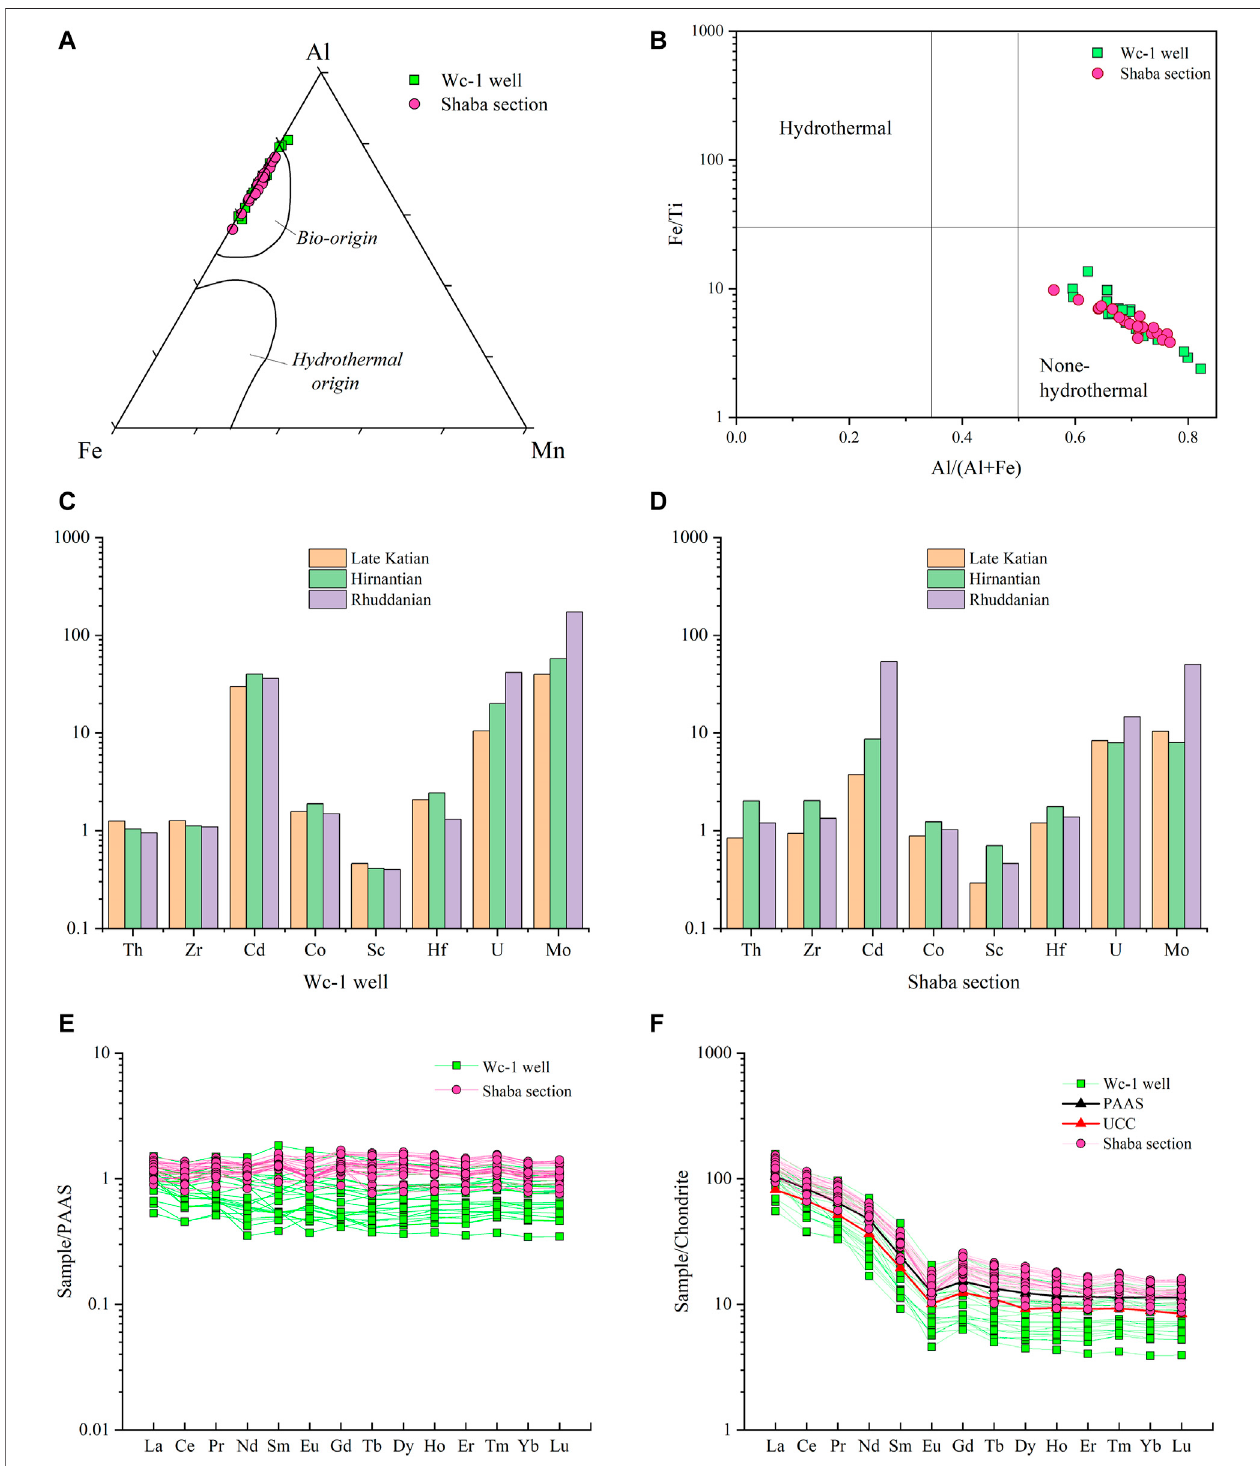
FIGURE 4 | (A) Source of shales in Wc-1 well and Shaba section analyzed by Al – Fe – Mn triangulation (Wedepohl, 1971; Adachi et al., 1986). (B) Al/(Al + Fe) – Fe/Ti diagramofWc-1wellandShabasection(Zhangetal.,2017). (C) EnrichmentoftraceelementinWc-1welland (D) Shabasection. (E) PAAS-normalizedREEpatternsof Wc-1 well and Shaba section samples. (F) Chondrite-normalized REE patterns of Wc-1 well, Shaba section, PAAS, and UCC (Rudnick and Gao, 2003).